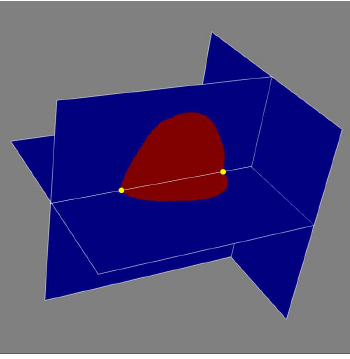
Figure 4. Two orthogonal planes are segmented in red, and the resulting intersection points are depicted in